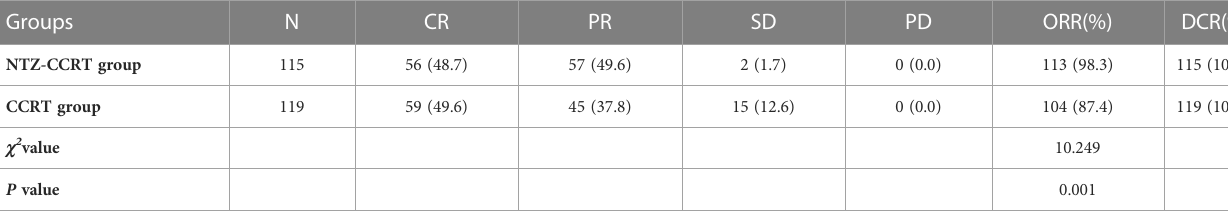
TABLE 3 Comparison of short-term ef fi cacy in cervical positive lymph nodes patients.